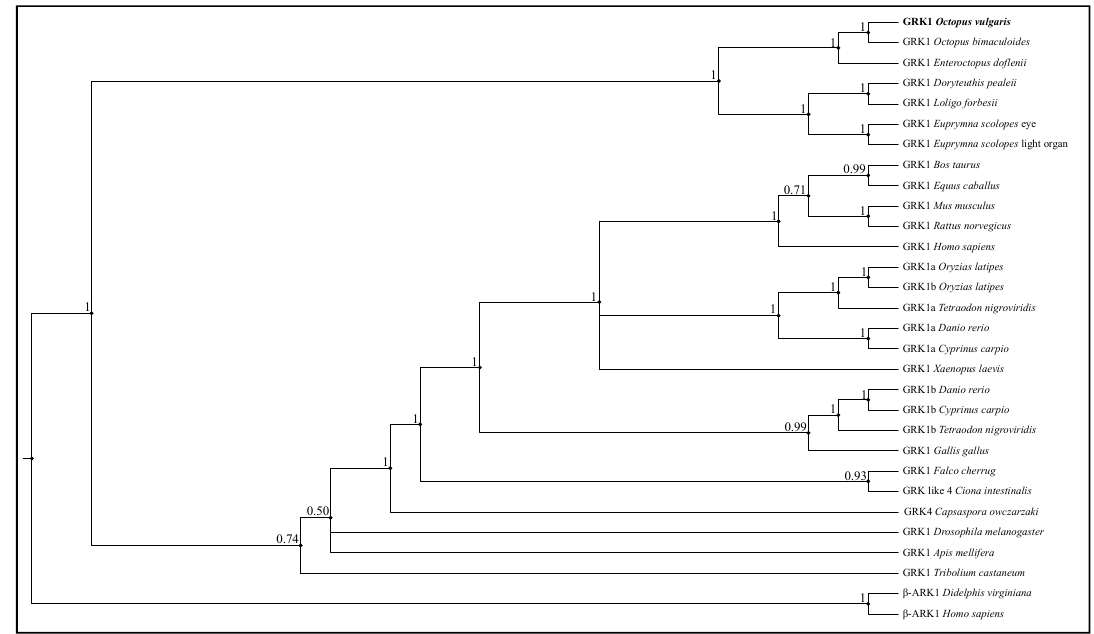
Figure 5. Bayesian tree of GRK protein sequences. Bayesian phylogenetic tree performed with LG + G model, constructed with protein sequences from Ov-GRK1 and Rhodopsin kinase receptors of 18 species including other cephalopods, inver- tebrates and vertebrates. All protein sequences were obtained from GenBank and the accession numbers are presented in Table S1. Bayesian posterior probabilities are represented over nodes; turquoise box highlights the cephalopod clade and the Ov-GRK1 protein sequence is in